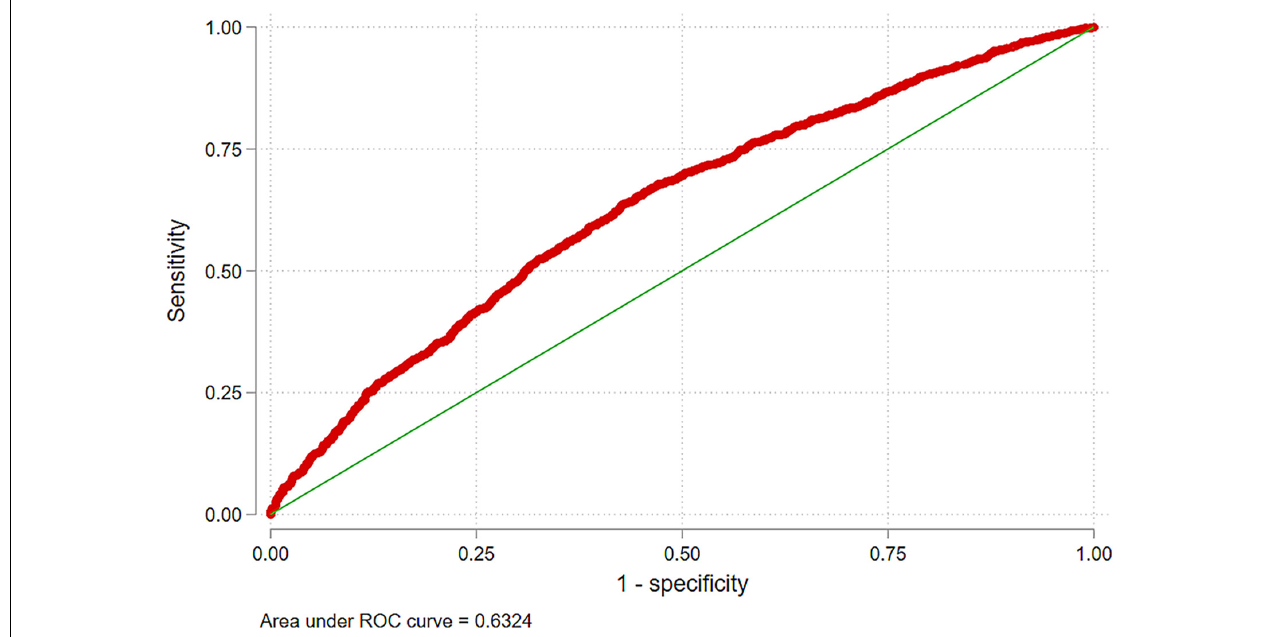
FIGURE 3 | A receiver operating characteristic (ROC) curve of the multivariable model to predict poor catch-up growth in SGA-LBW infants.